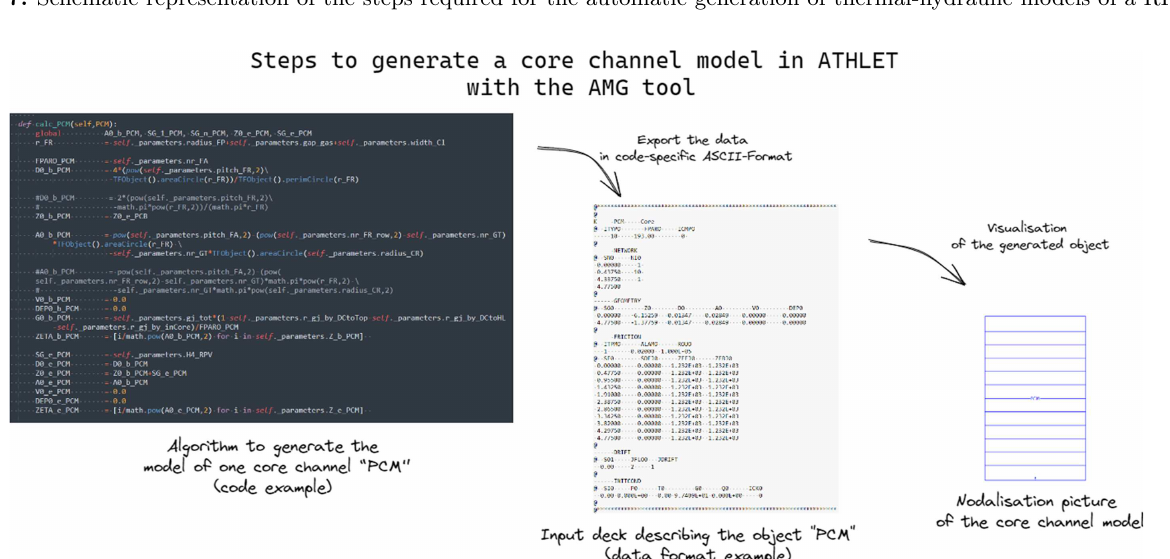
Fig. 7. Schematic representation of the steps required for the automatic generation of thermal-hydraulic models of a RPV.